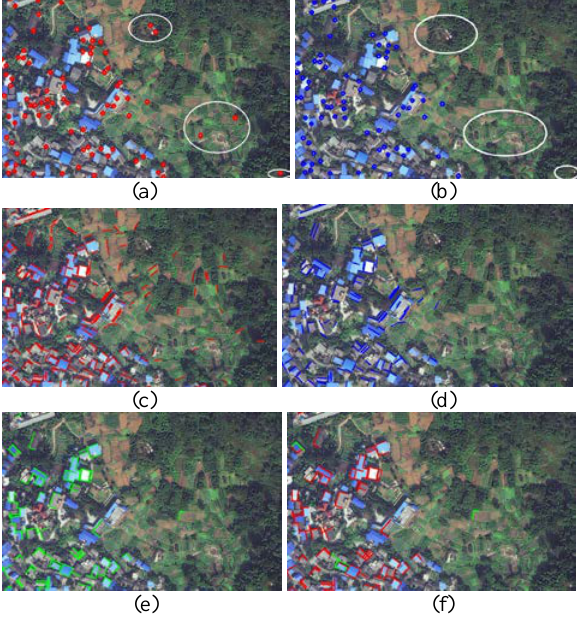
Fig.3 filter results of local image geometric features (a) original corner points, (b) final corner points, (c) original straight lines, (d) final straight lines, (e) original orthogonal angles, (green), (f) final orthogonal angles (red) Then we get the radiation intensity map of multi geometric features by the cumulative fusion of final corner points, final straight lines and final orthogonal angles which is shown in Fig.4.According to the radiation intensity map of multi geometric features, we can that the main artificial areas in the experimentation area are marked (white area). But some artificial areas are still missed, and the white areas are not continuous. It is impossible to accurately detect all the artificial areas only by the geometric features, so it is necessary to combine the visual saliency features to improve the accuracy of the detection.